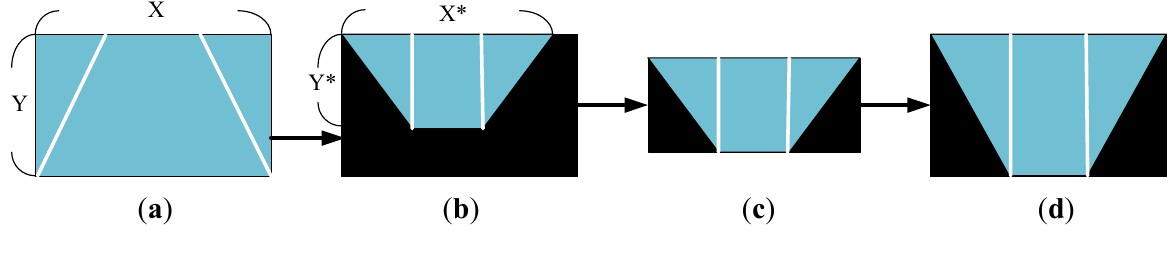
Figure 4. Procedures of TVTM. ( a ) Source perspective image; ( b ) Image after TVTM transformation; ( c ) Image after discard non-information part of (b); ( d ) Image resized from (c).